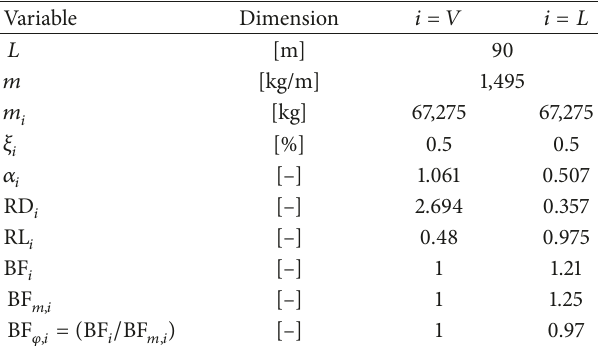
Table 4: Dynamiccharacteristics ofthetrussfootbridge. 𝑚 𝑉 and 𝑚 𝐿 are evaluated considering a simply supported beam; that is, RL 𝑖 = 0